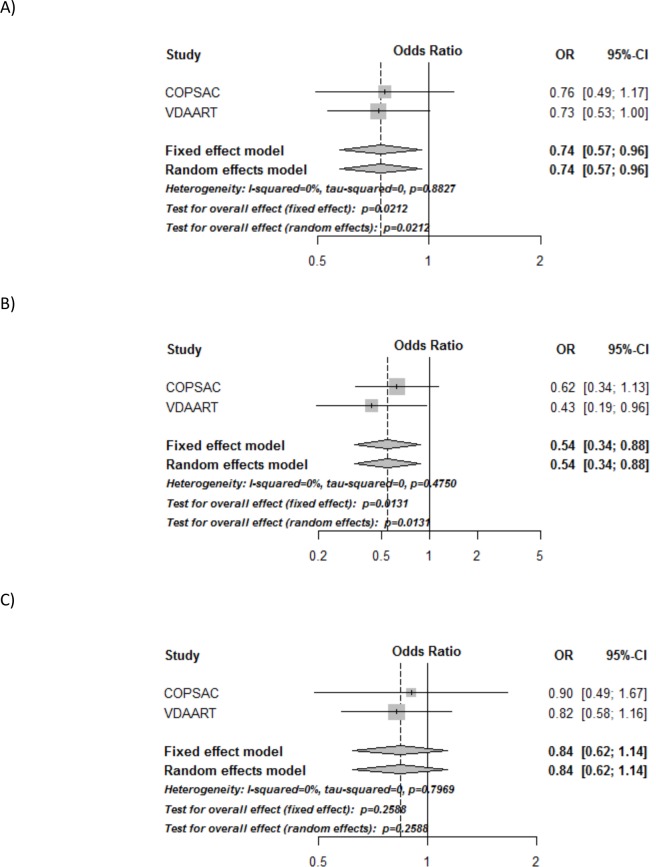
A) The VDAART participants flow, B) The COPSAC2010 participants flow.